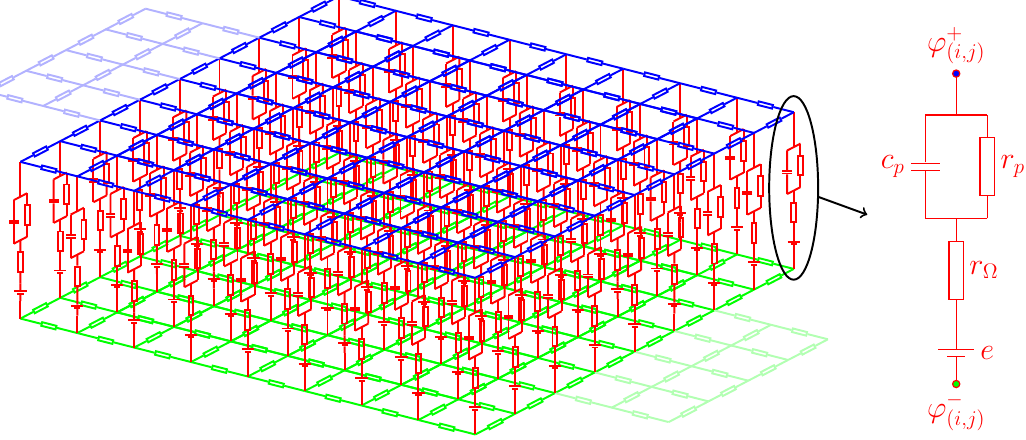
Figure 9. Distributed parameter equivalent circuit model (DPECM)